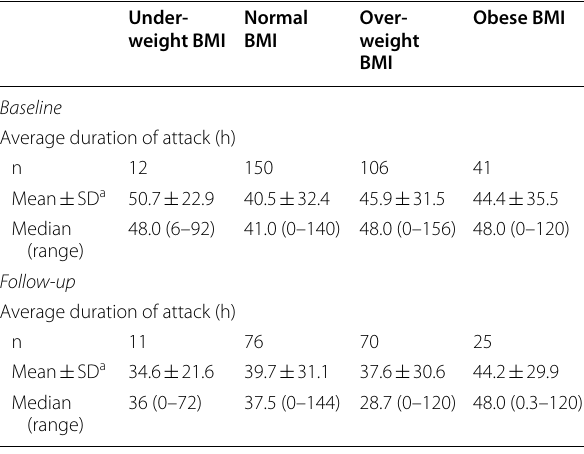
Average duration of untreated attacks corresponds to mean of average durations of untreated attacks at the skin, abdomen, larynx, and other sites BMI body mass index; SD standard deviation; n a P values comparing average duration of attack at baseline between patients with normal/overweight/obese BMI: P Results excluding data from the two reinjection outliers are presented